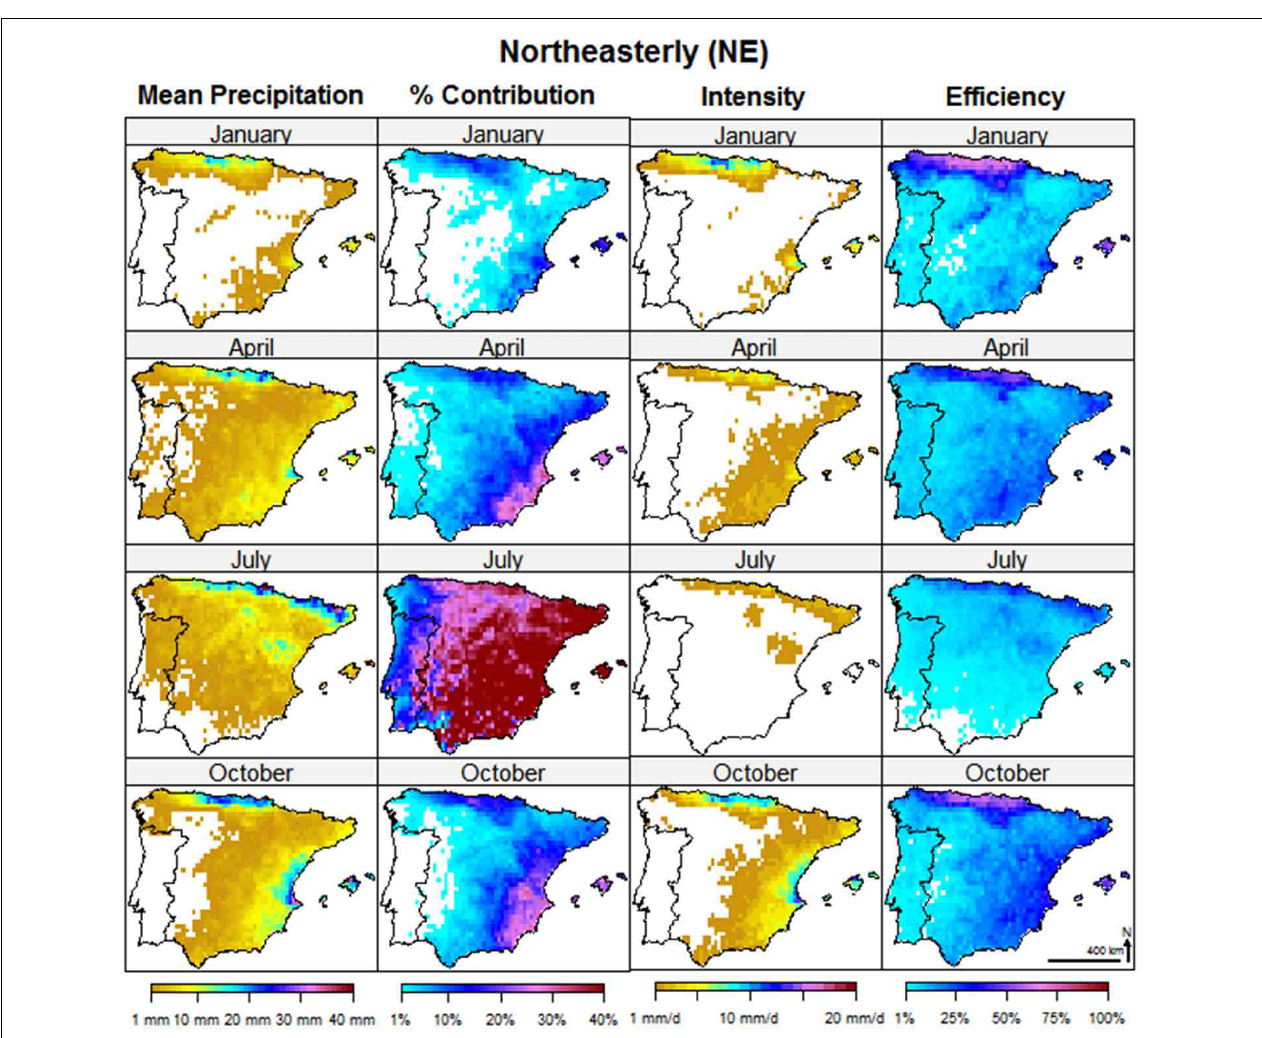
FIGURE 7 | As Figure 5 but relative to the Northeasterly (NE)